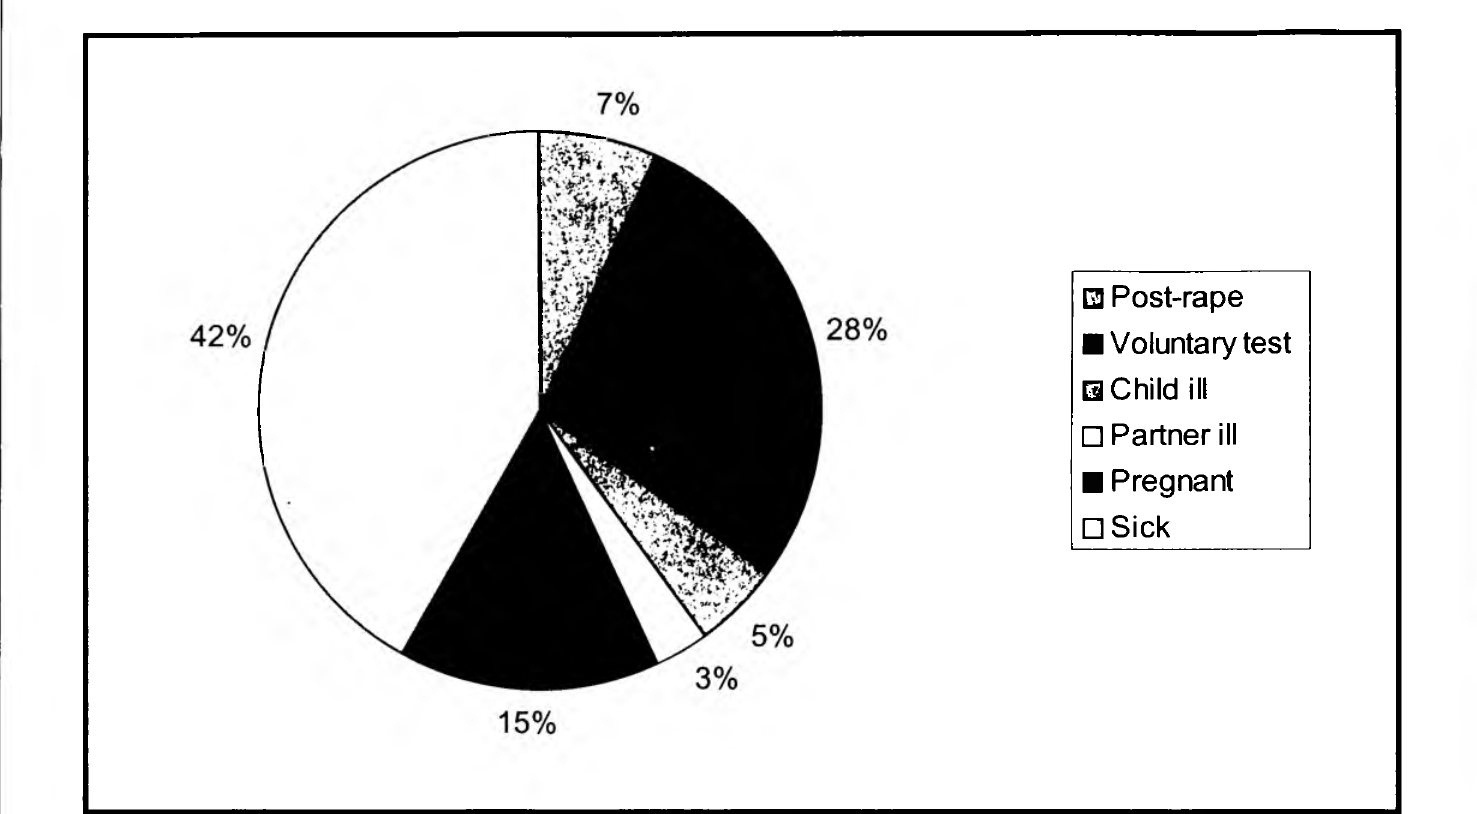
Figure4 Disclosure of HIV+ve status to other